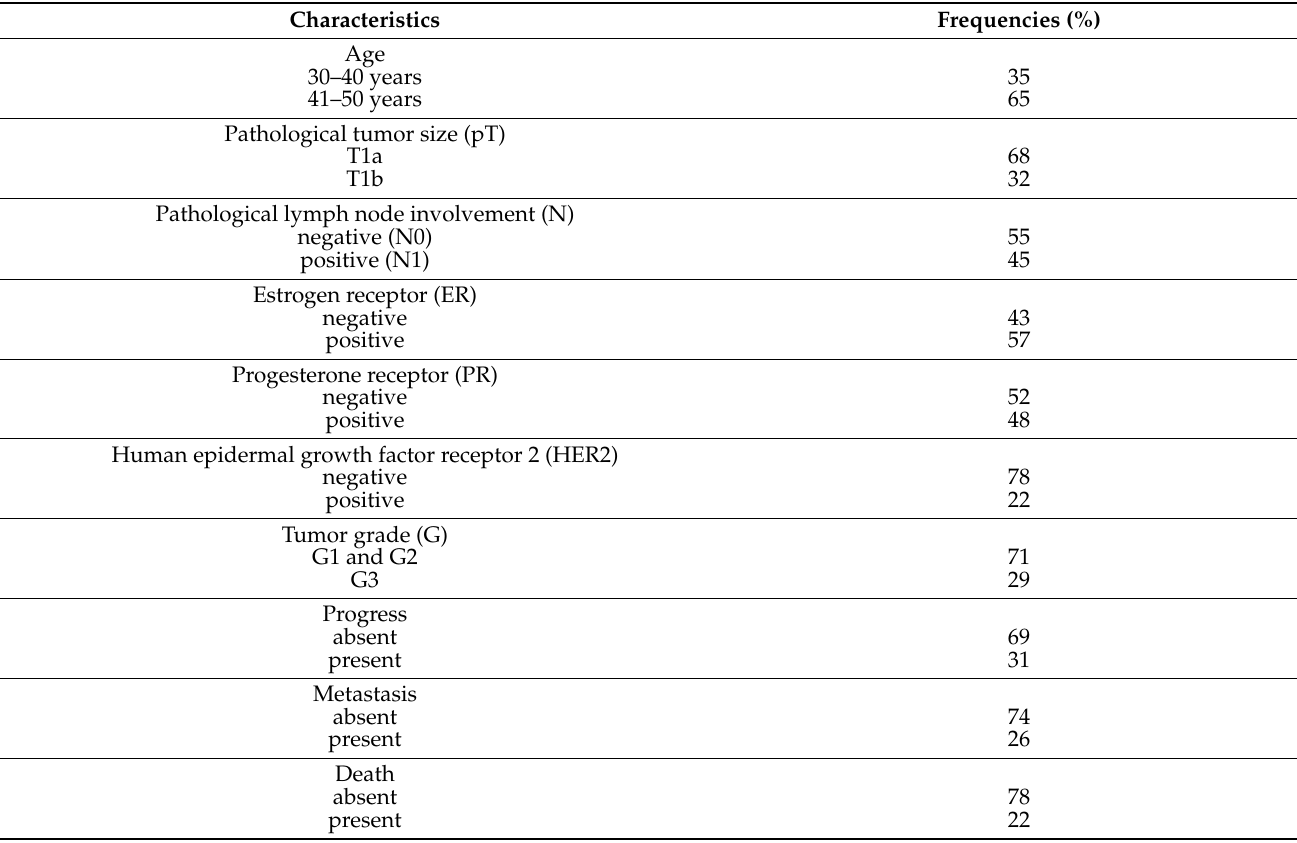
Table 3. The clinicopathological characteristics of the study group.